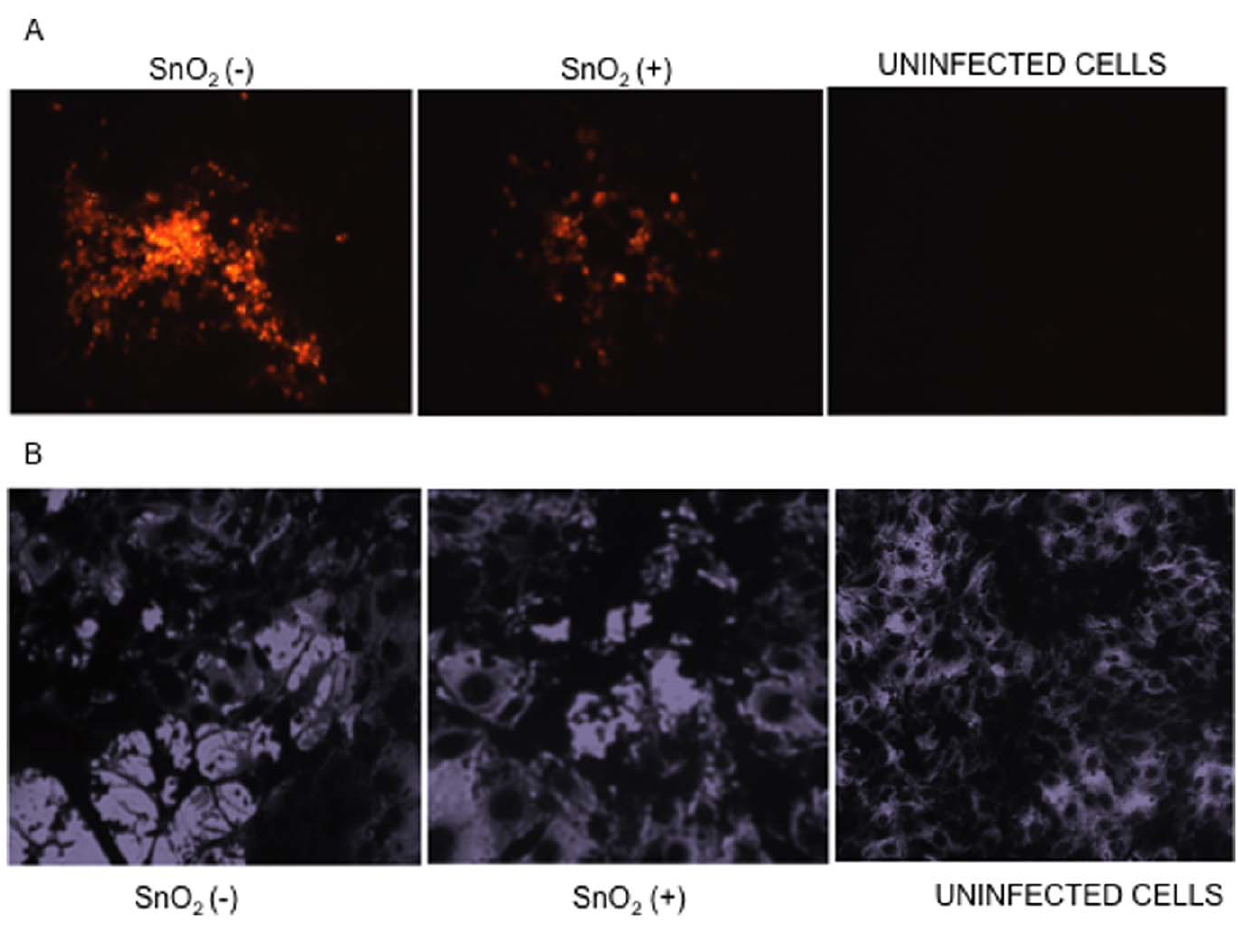
Figure 4. SnO 2 Inhibits cell-to-cell spread and plaque formation in HCE cells. A) Confluent monolayers of HCE cells were infected with HSV- 1 (KOS) K26RFP and viral replication and spread were imaged 72 hours post infection. The effect of SnO 2 on viral spread was assayed through the measurement of infected cell clusters and the intensity of RFP emission. B) In conjugation with the infectious spread assay, a plaque assay was performed to evaluate the SnO 2 effect on viral transmission. UV treated SnO 2 was added to cells prior to a 2 hour incubation with HSV-1(KOS). Following the 2-hour absorption phase virus inoculum was removed and cells were overlaid with methylcellulose. 3-days post infection cells were fixed with methanol at room temperature for 20 minutes and strained with crystal violet. Images were taken with a Zeiss Axiovert 200 microscope using a 10 6 objective.